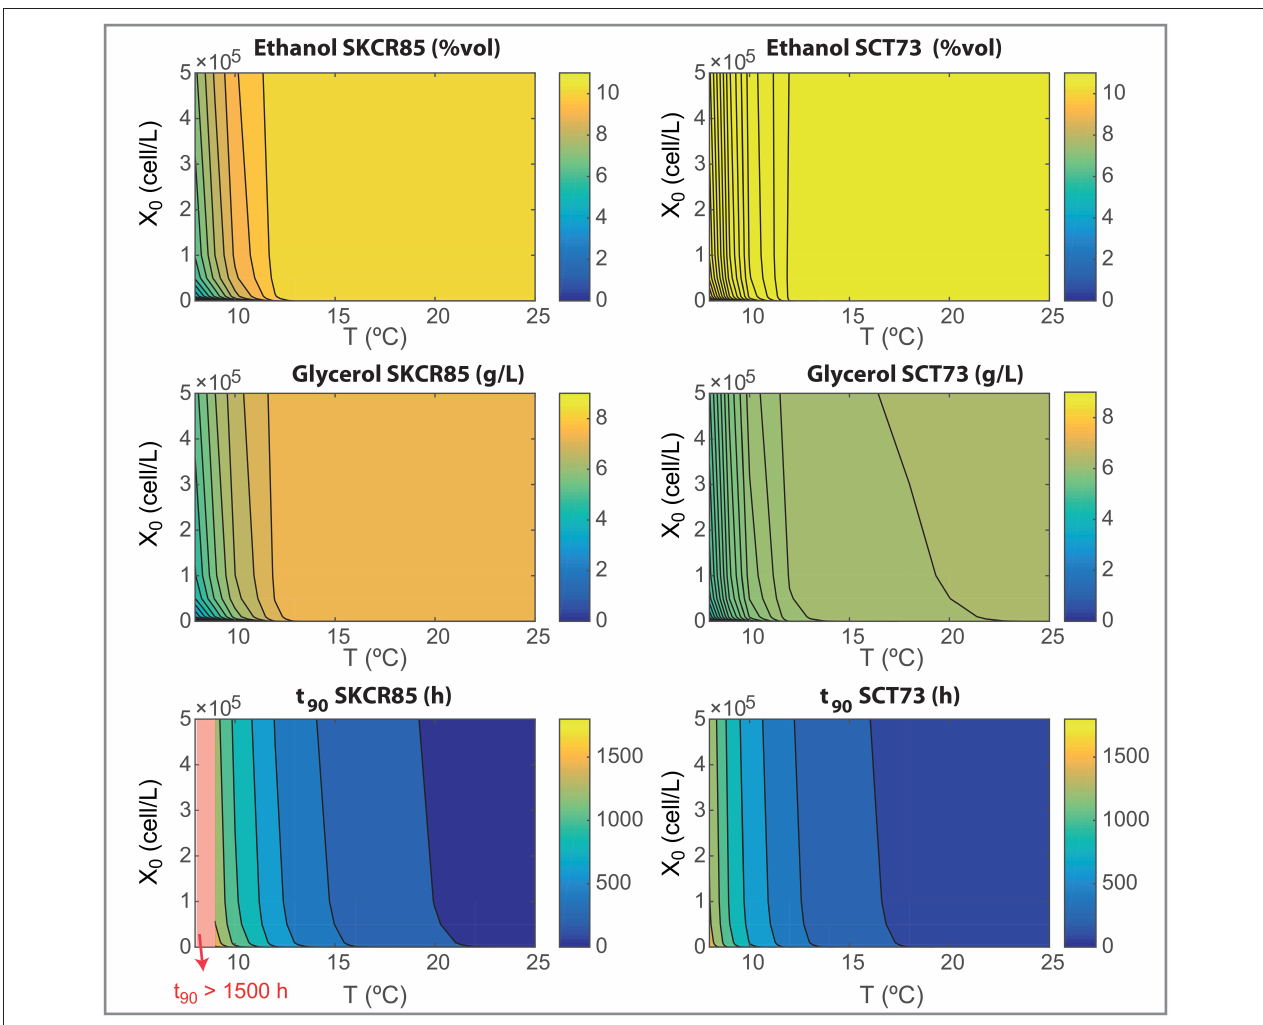
FIGURE 7 | Wine final composition and t 90 as functions of the initial inoculation and the fermentation temperatures for both species as obtained with the ensemble model